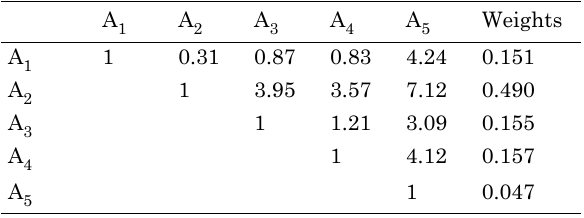
Table 8. Pairwise comparison judgment matrix of each type of exterior walls in the index of construction